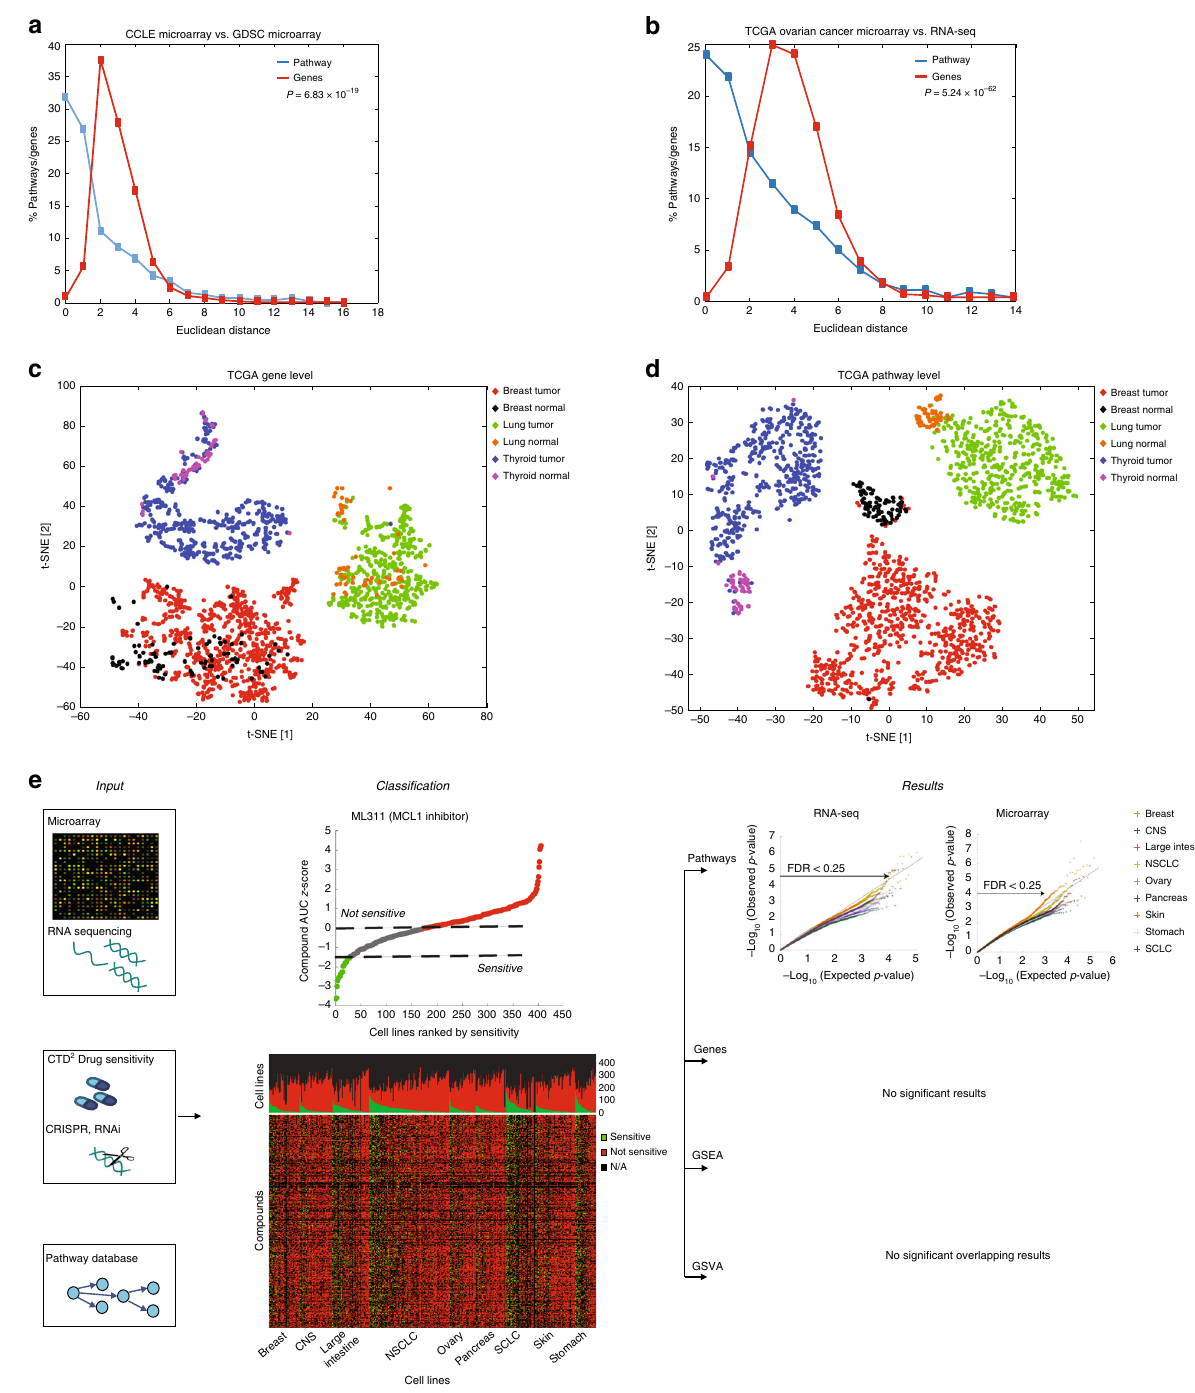
Fig. 1 Pathway activity levels as predictive biomarkers. a Euclidean distance (ED) distribution of genes and pathways calculated from microarray data from two different institutions (CCLE and GDSC) across 438 cell lines. Blue line: ED distribution between the pathways in the two datasets; red line: ED distribution between the genes. P- values were generated using Mann – Whitney U -test. b ED distribution of genes and pathways between RNA-seq and microarray data across 294 ovarian cancer patients. Blue line: ED between the pathways; red line: ED between the genes. P -values were generated using Mann – Whitney U -test. c tSNE plot of the gene-expression levels in three tumor types and their adjacent normal tissue. Samples are colored by tissue type and state (tumor/normal). d tSNE plot of the pathway activity levels in three tumor types and their adjacent normal tissue. Samples are colored by tissue type and state (tumor/normal). e Work fl ow pipeline depicting the data fl ow from the (i) Input data to (ii) the drug-based Classi fi cation step to (iii) the fi nal Results output. The quantile – quantile (QQ) plots are colored by tissue type. See also Supplementary Figs. 1 –